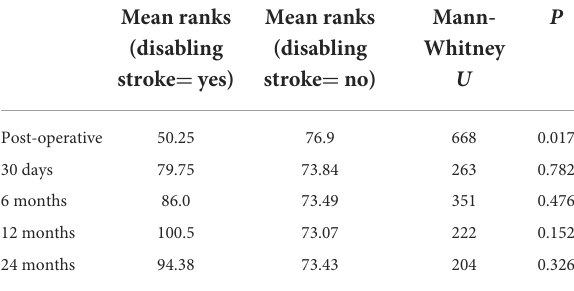
TABLE 7 Endovascular time mean ranks vs. disabling strokes in each period.